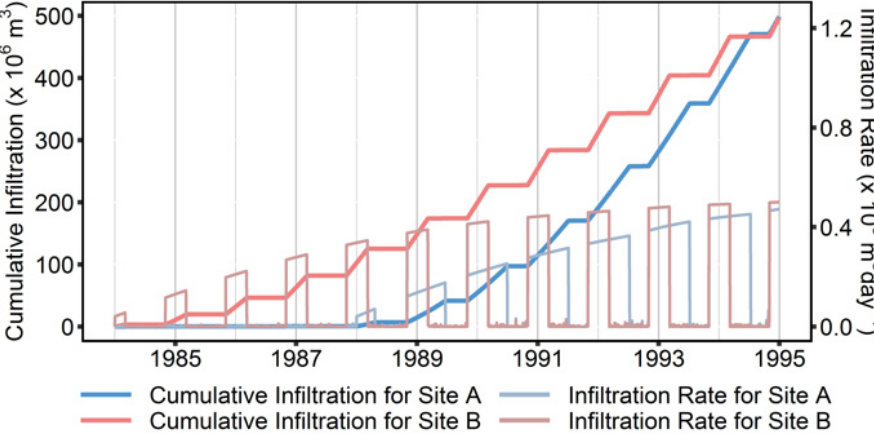
Figure A3. Infiltration rate and its accumulations for Site A and Site B.